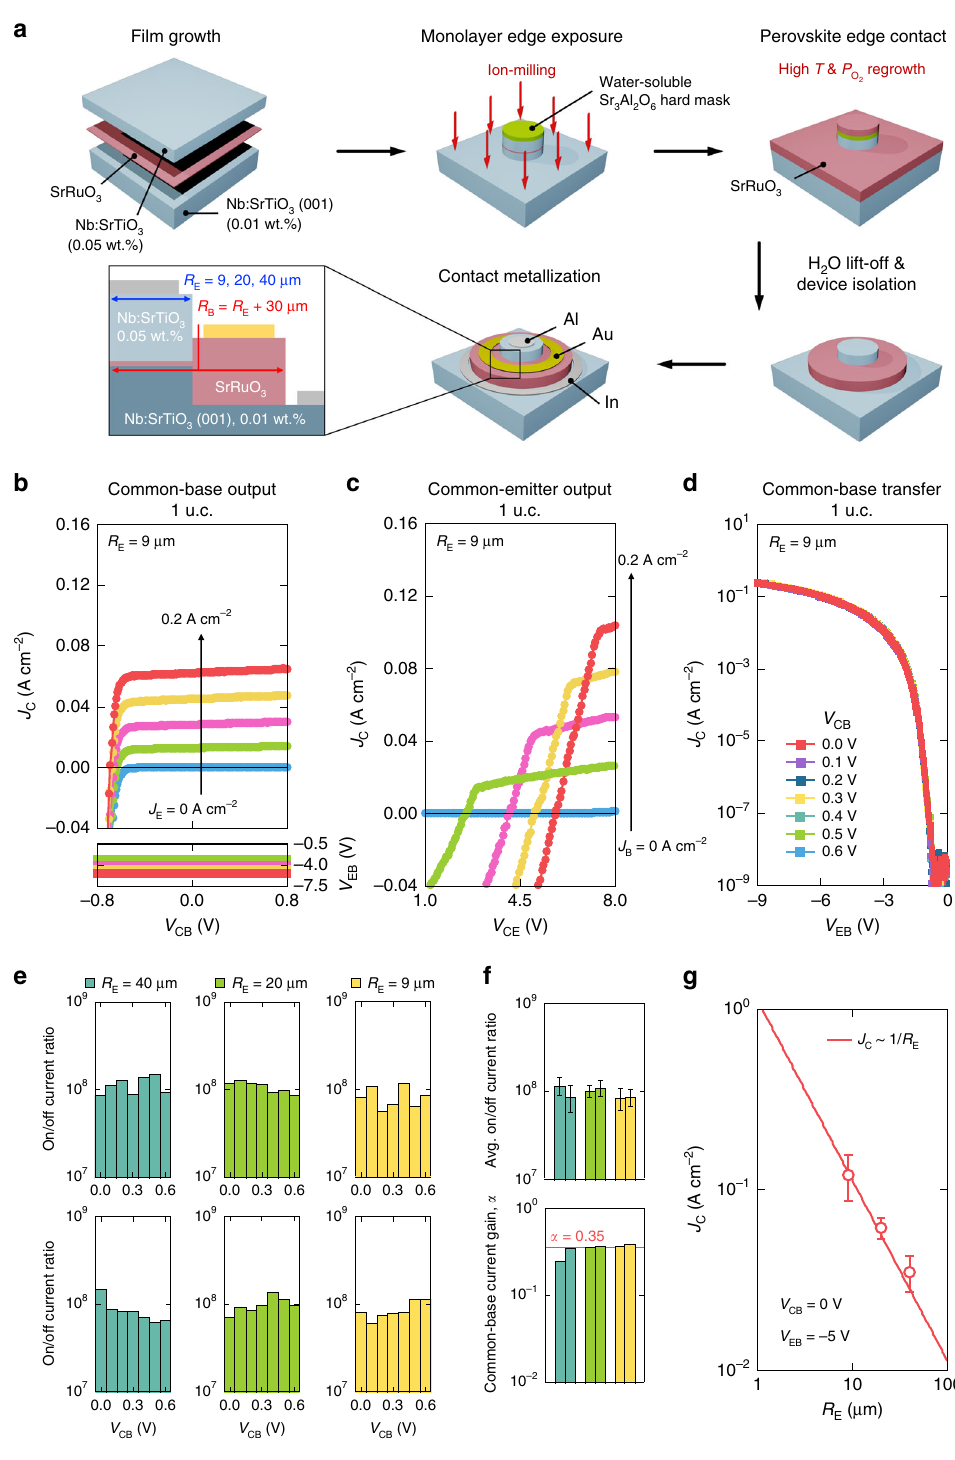
Fig. 5 Room-temperature electrical characterization of monolayer-base HETs with a perovskite one-dimensional electrical edge contact. a Schematic of the perovskite edge contact fabrication process using a water-soluble and growth-compatible Sr 3 Al 2 O 6 hard mask layer 30 . R E ( R B ) is the emitter (base) radius. b Common-base output characteristics (top) and voltage feedback (bottom), as J E is increased from 0 to 0.2 A cm − 2 , in 0.05 A cm − 2 steps. c Common- emitter output characteristics, as J B is increased from 0 to 0.2 A cm − 2 , in 0.05 A cm − 2 steps. d Common-base transfer characteristics with V CB ranging from 0.0 to 0.6 V, in 0.1 V steps. R E is 9 μ m for the devices shown in b through d . e On/off current ratio as a function of V CB ranging from 0.0 to 0.6 V, in 0.1 V steps. Each panel represents a different device. f On/off current ratio averaged over V CB ranging from 0.0 to 0.6 V (top) and common-base current gain α (bottom) for devices shown in e . The red solid line represents α = 0.35, each bar represents a different device, and the error bars represent the standard deviations. The blue, green, and yellow solid bars in e and f represent devices with R E = 40, 20, and 9 μ m, respectively. g J C as a function of R E at V = 0 V and V = − 5 V. The error bars represent the standard deviations. The data (red open circles) self-consistently scale with the residual base CB EB resistance underneath the emitter as J C ~ 1/ R E (red solid line) 31